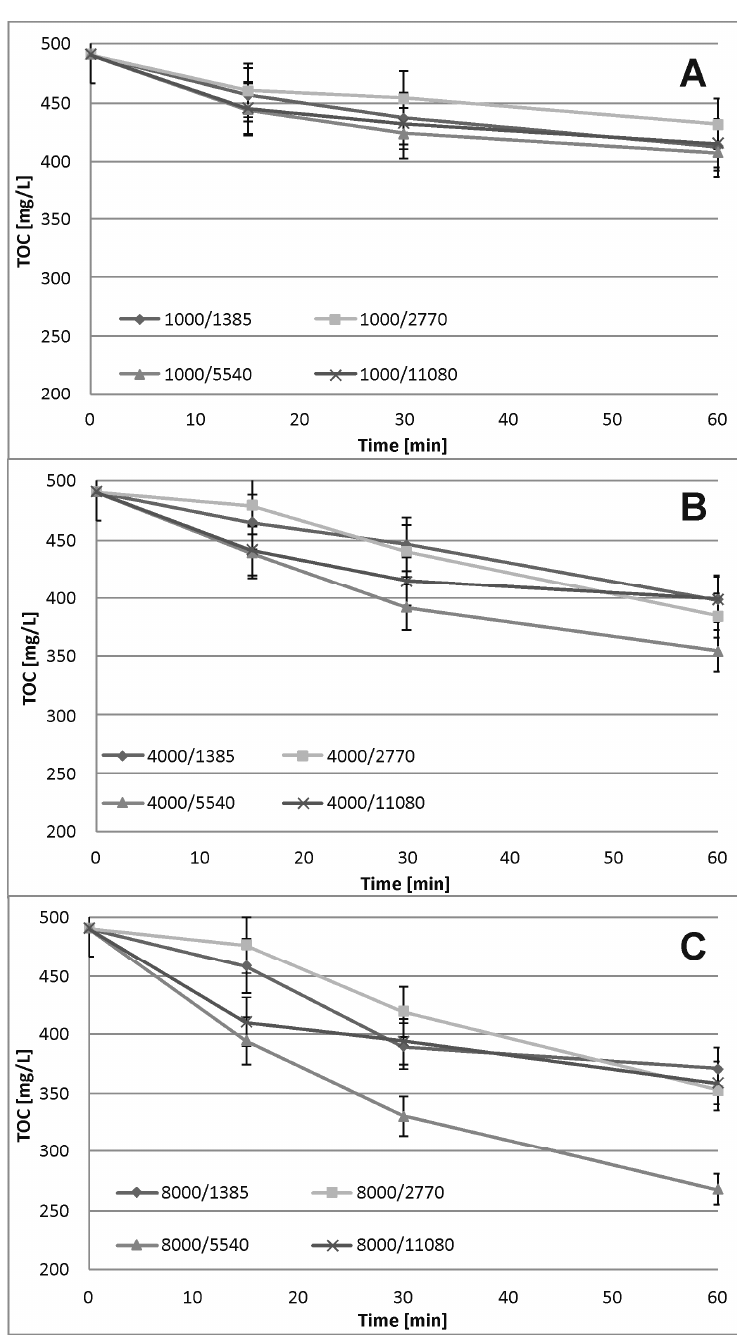
Figure 5. TOC removal during the Fe 0 /H 2 O 2 process after coagulation at pH 6.0 as pretreatment for selected Fe 0 /H 2 O 2 [mg/L] reagent doses.